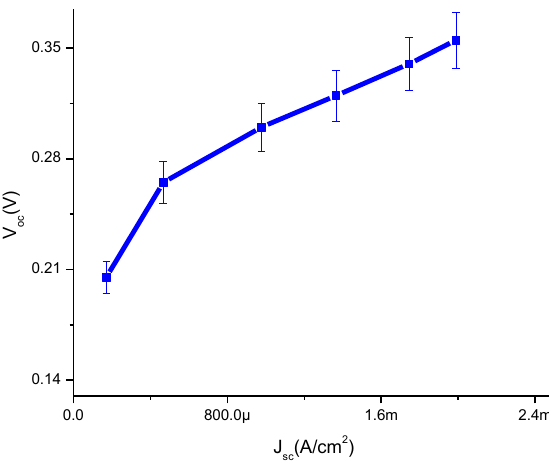
Figure 5. Plot of open circuit voltage against current density.